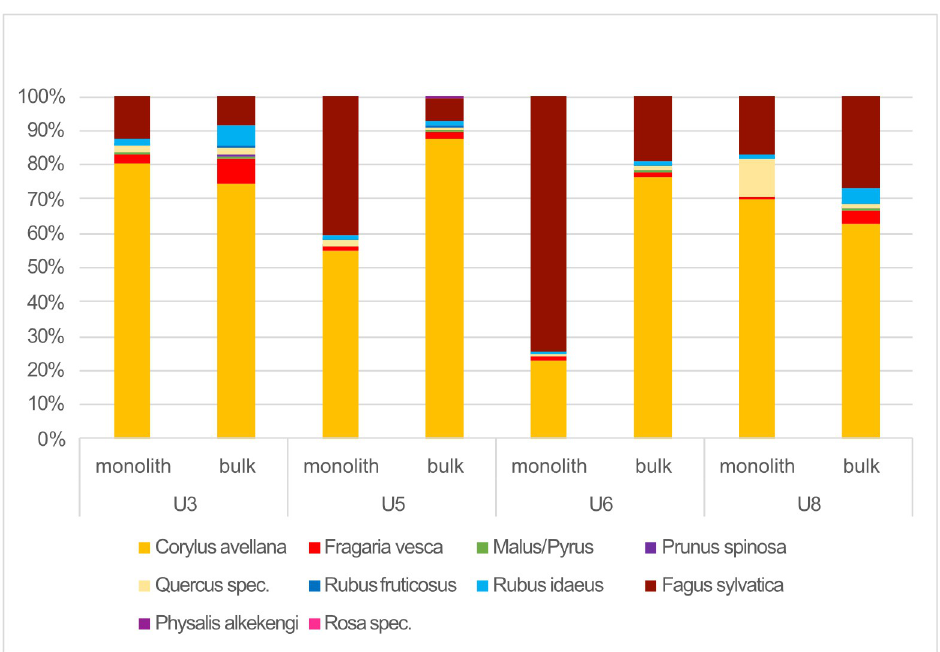
Fig 16. Caloric input based from gathered fruit